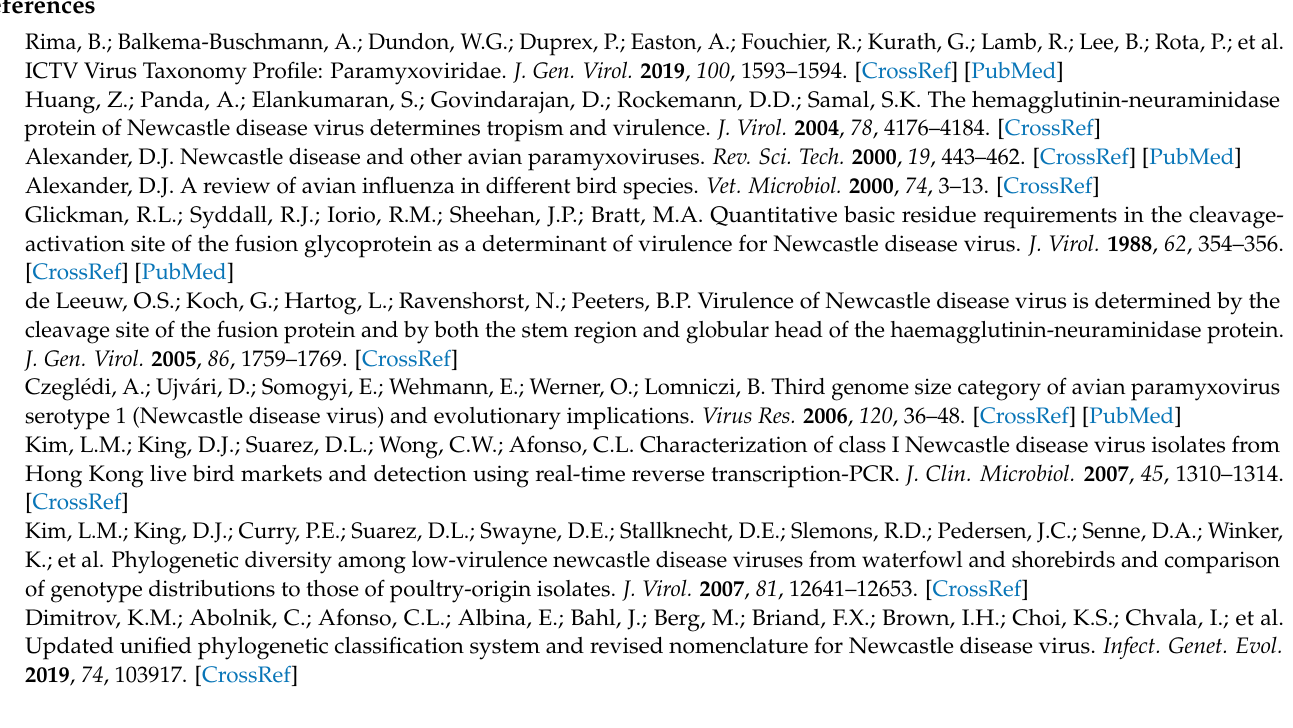
Table S3: Gross pathological changes in chickens experimentally infected with NDV isolates N5 and LT67 (number of birds having the lesions shown in